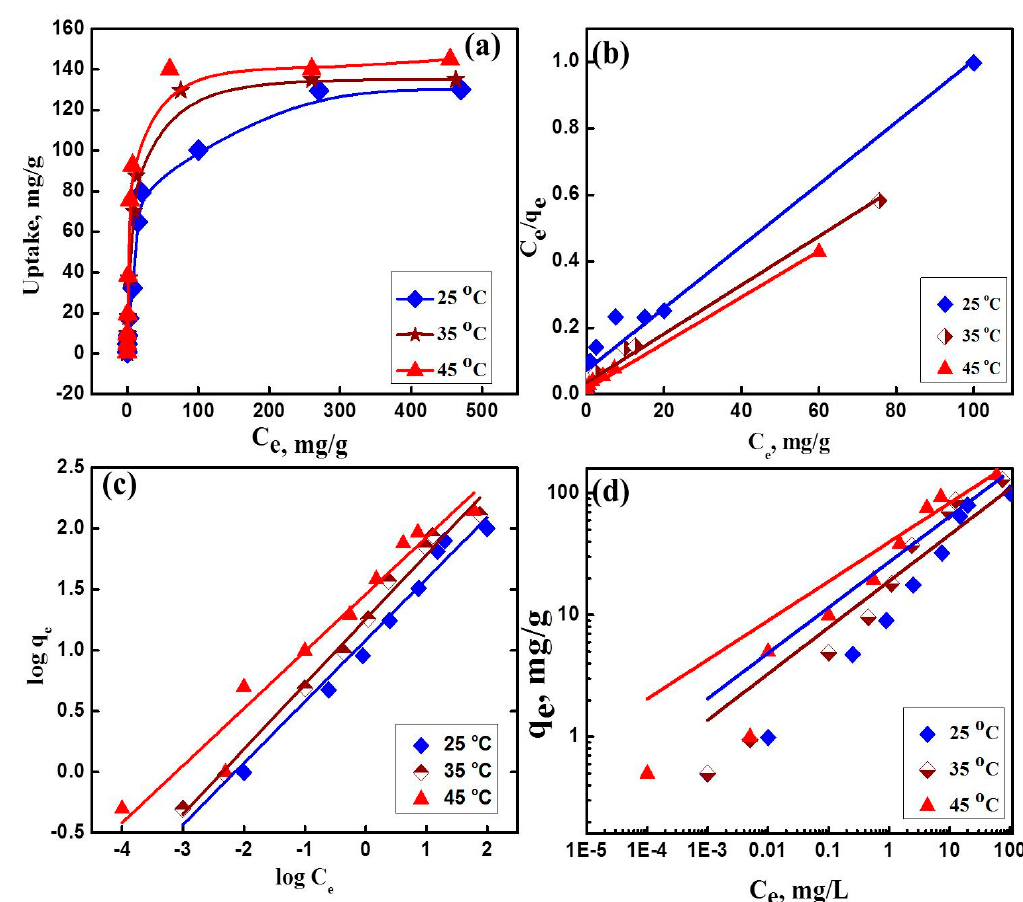
Figure 7. ( a ) Adsorption isotherm of uranyl ions adsorption on NaZrP-CEX from a single ion solution; pH 4.5, ZrP-CEX weight 20 mg, solution volume 20 mL, contact time 2 h at different temperatures (25, 35 and 45 °C). ( b ) Langmuir plot, ( c ) linear Freundlich plot, and ( d ) nonlinear Freundlich plot of the adsorption of uranyl ions on NaZrP-CEX at different temperatures. Table 2. Comparison of the adsorption capacities of U(VI) ions onto various inorganic absorbents. Adsorbent Uptake, mg/g Ref. Zinc MOF carboxylate 114.70 [45]